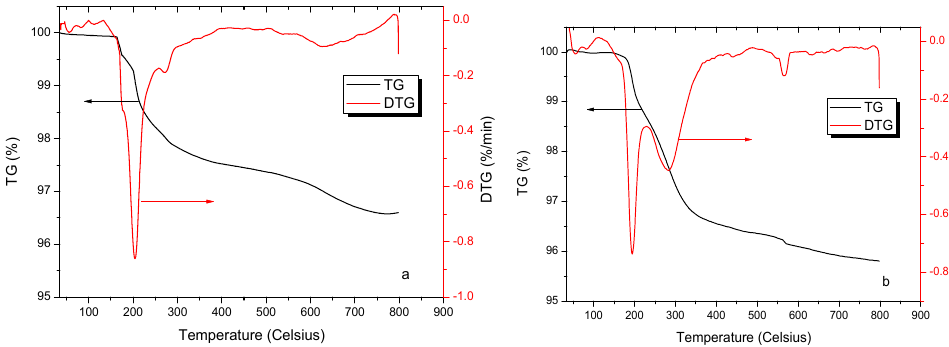
Figure 9. Thermogravimetry/derivative thermogravimetry (TG/DTG) curves of the LBSP and compound ( a ) LBSP; ( b ) PCE/LBSP compound.